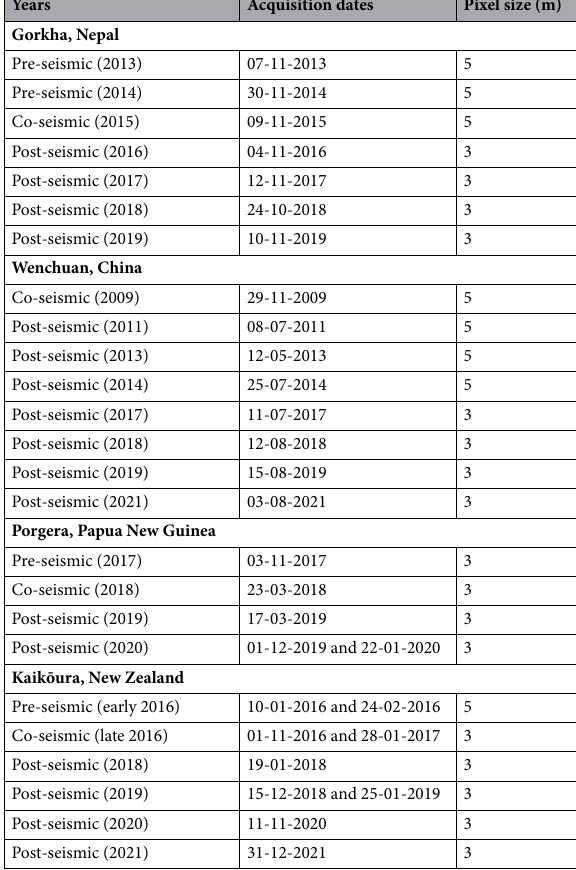
Table 5. Information about the satellite images for each